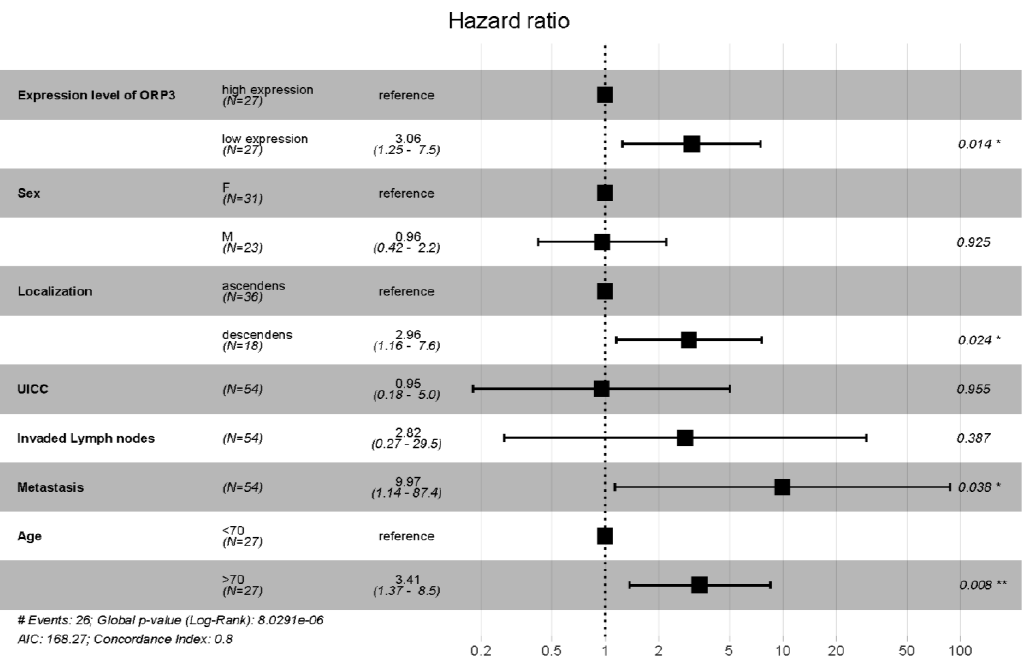
Figure 4. Hazard ratio calculated using a cox proportional-hazards analysis of patients with a grade 3 tumor. The factor grade was, therefore, masked from this analysis. Hazard ratios > 1 indicate an increased risk of dying. While hazard ratios < 1 indicate a beneficial outcome for the patient. p -values of each individual factor based on the multivariate analysis is depicted on the right of the figure with the values: * indicates p < 0.05, ** indicates p < 0.01.